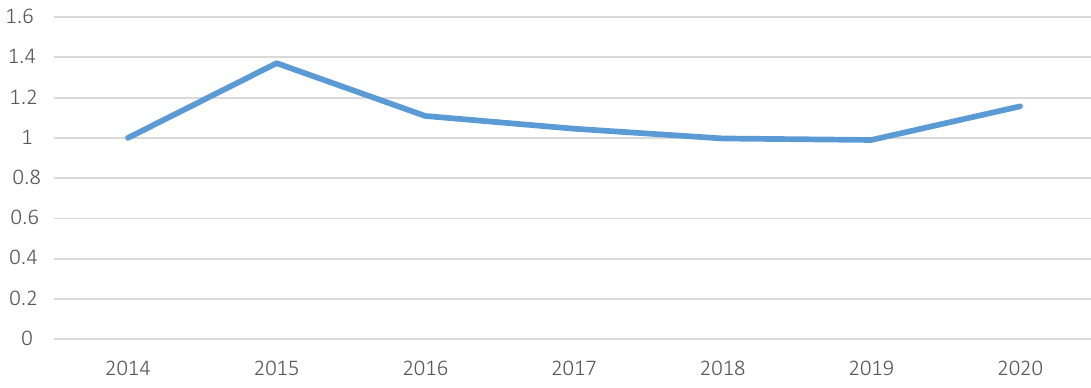
Figure 5. Dynamics of the professional index of insurance interest